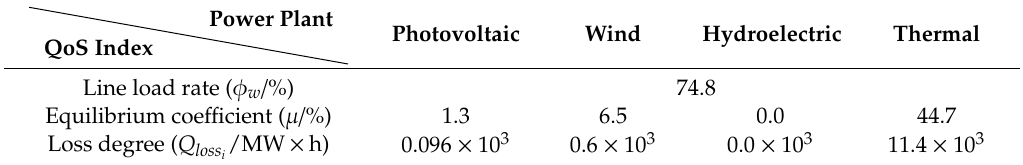
Table 3. Energy flow QoS index evaluation results.